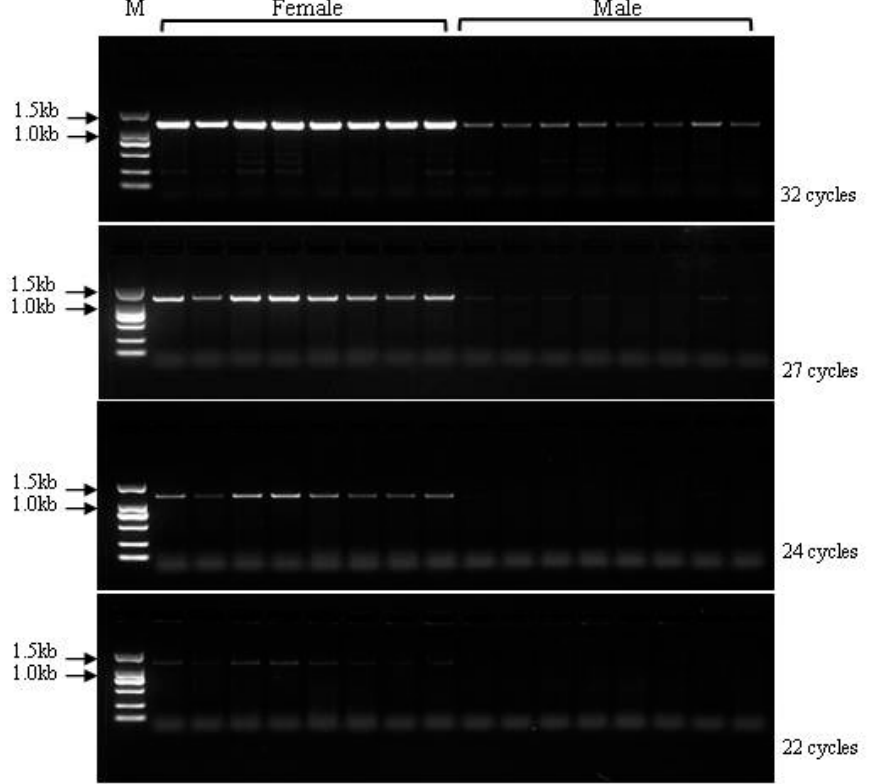
Figure 5. Detection of sex-specific marker ps3137s1 in male and female Pelodiscus sinensis populations.